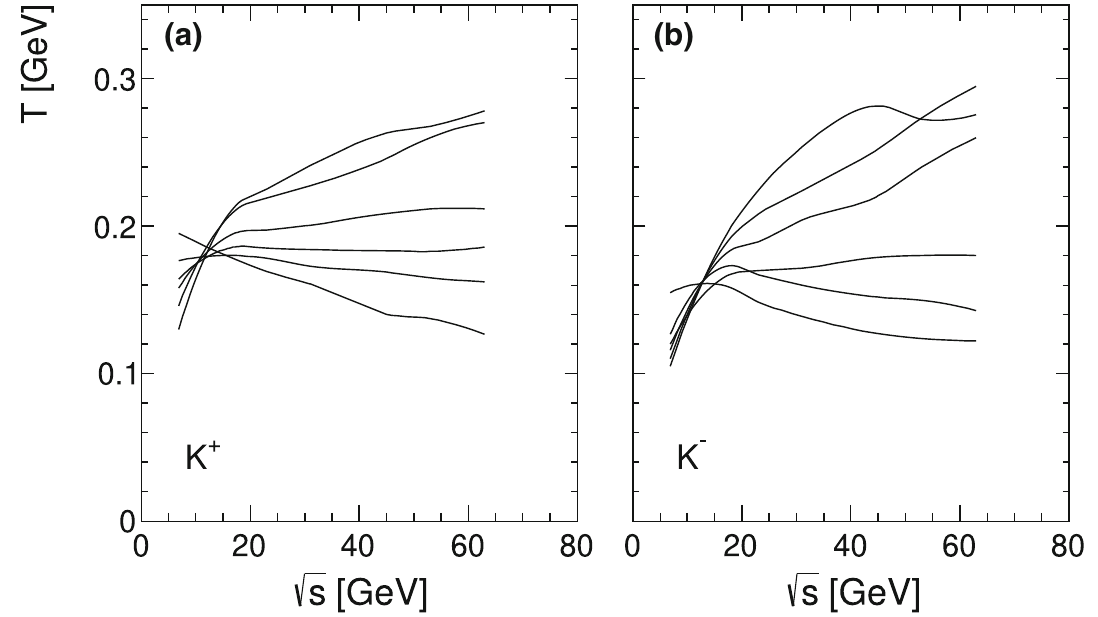
√ s for a K + and b K